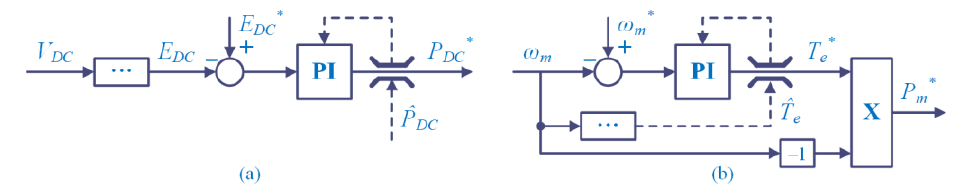
Figure 4. Schematic representation of the ( a ) V DC loop and ( b ) speed loop.